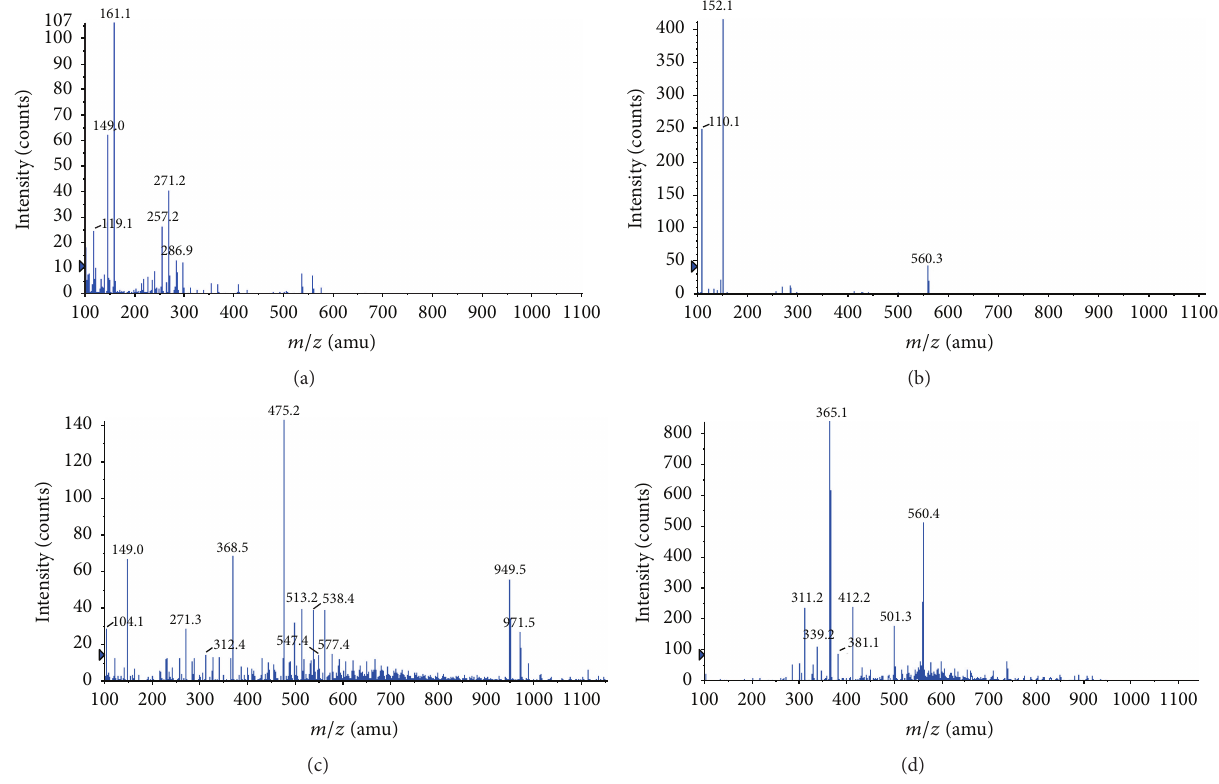
Figure 2: Mass spectra from direct tablet analysis using nano-DESI MS; (a) ibuprofen containing tablet, showing ibuprofen specific fragment ions at m/z 119 and 161, (b) paracetamol containing tablet, showing paracetamol specific fragment ions at m/z 110 and 152, (c) sildenafil containing tablet, showing specific sildenafil m/z 475 ion and m/z 513 ion, and (d) tadalafil containing tablet, showing specific tadalafil m/z 412 ion and lactose m/z 365 ion.